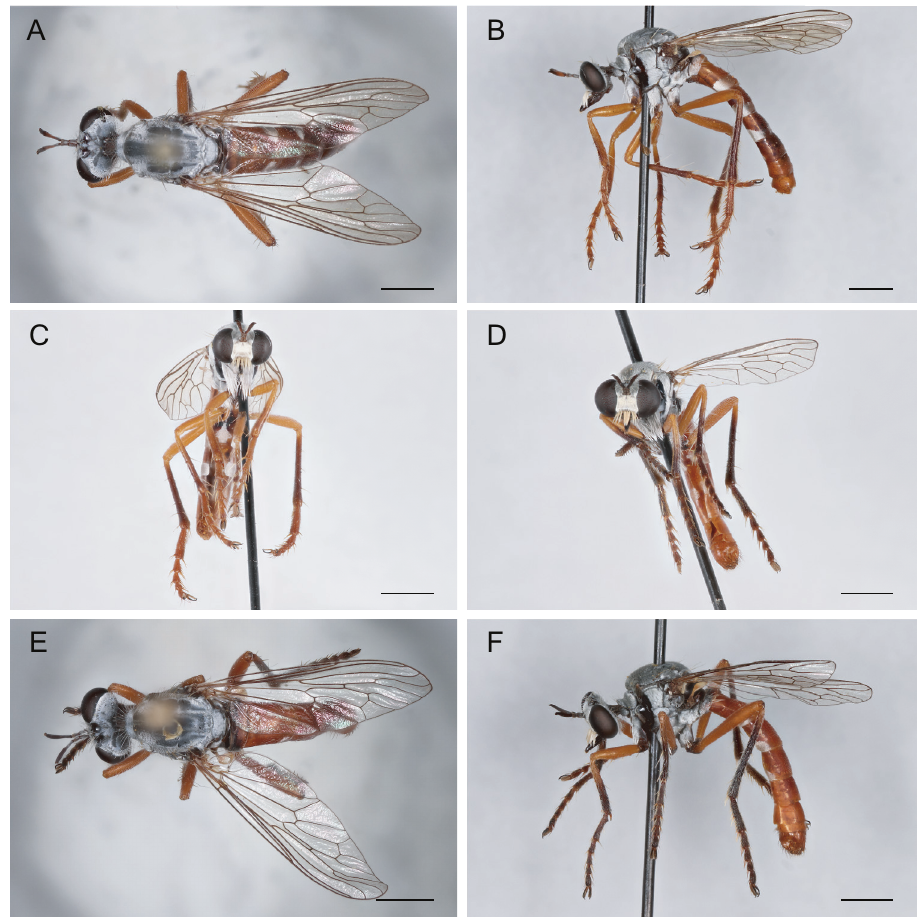
Figure 19. Saropogon nitidus Wilcox, 1966 Female (USNMENT01830081): A dorsal view B lateral view C anterior view; Male (UCBMEP0280497): D anterior view E dorsal view F lateral view. Scale bars: 2